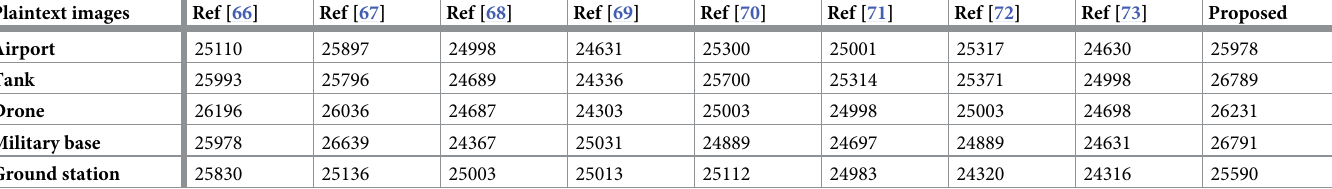
Table 4. Maximum deviation.